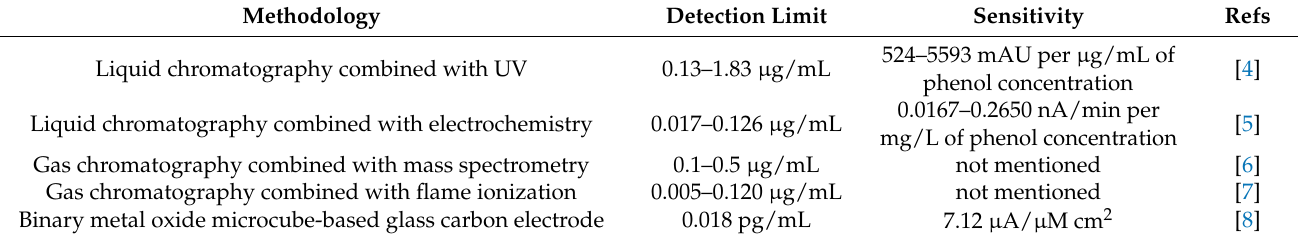
Table 3. Comparison of the tyrosinase metal-supported lipid membrane sensor developed herein with other methodologies for the detection of phenol in water